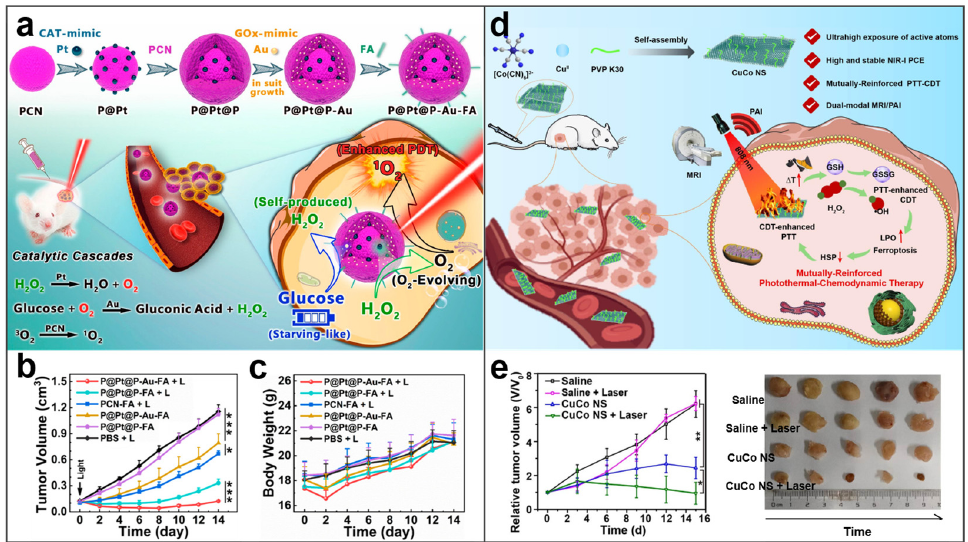
Figure 12. BMNs used in combination treatment with two therapies. ( a ) Schematic illustration of the catalytic cascades − enhanced synergistic cancer therapy. Reprinted with permission from Ref. [12]. ( b ) Tumor growth curves and ( c ) body weight changes of the 4T1 tumor − bearing mice in six groups. Reprinted with permission from Ref. [12]. Copyright © 2022 American Chemical Society. ( d ) Schematic illustration of the synthesis procedure for CuCo NS and proposed therapeutic mechanism of mutually reinforced PTT − CDT. Reprinted with permission from Ref. [131]. ( e ) The therapeutic effect of CuCo NS against tumors. Adapted with permission from Ref. [131].